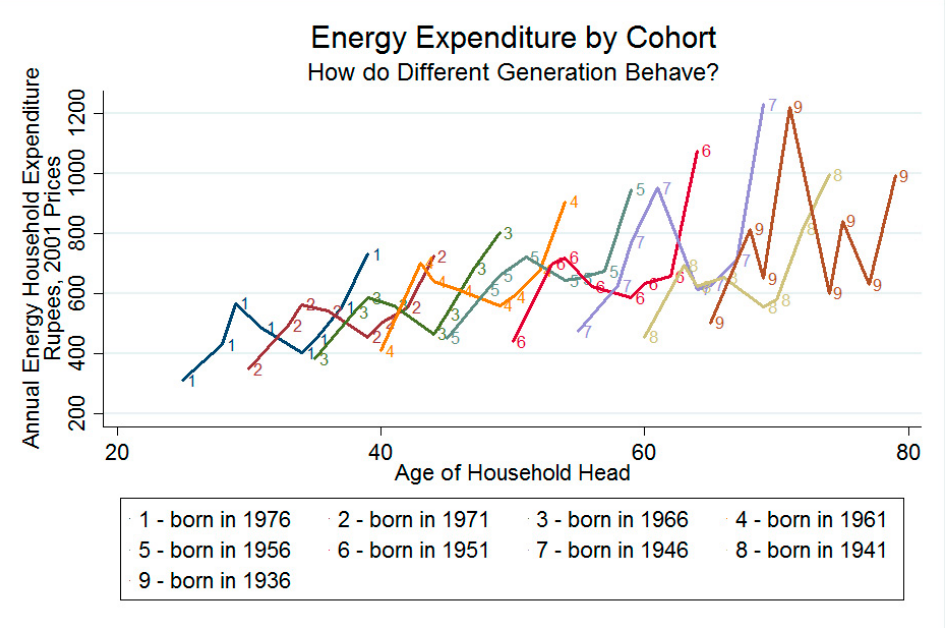
Figure 4. Age of Household Head.